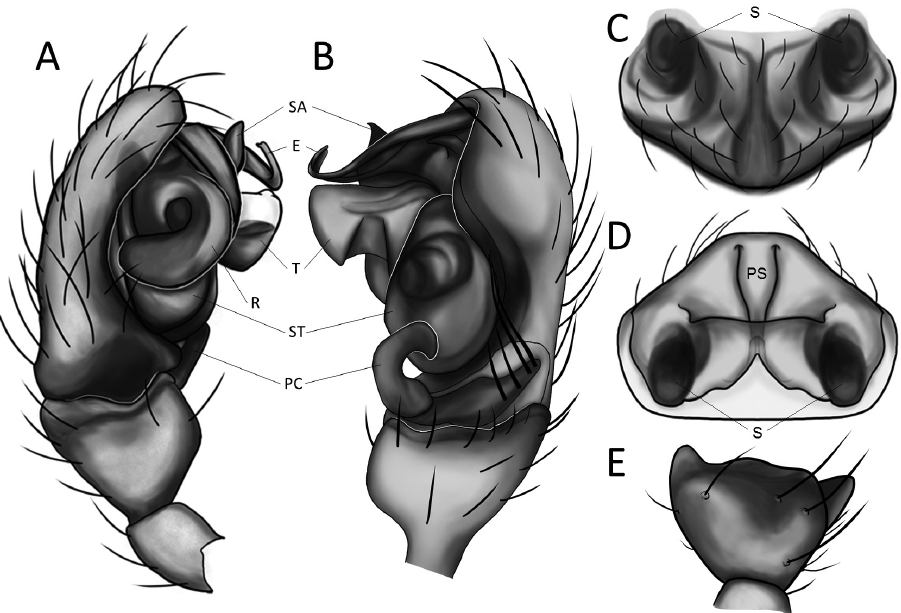
Figure 2. Illustrations of Islandiana lewisi sp. n. structures. A Left palp of male, medial view B Left palp of male, lateral view C Epigynum, ventral view D Epigynum, flipped – dorsal view E Tibial apophysis of left palp of male. E = Embolus; R = radix; SA = suprategular apophysis; ST = subtegulum; T = tegulum; PC = paracymbium; S = spermathecae; PS = posterior